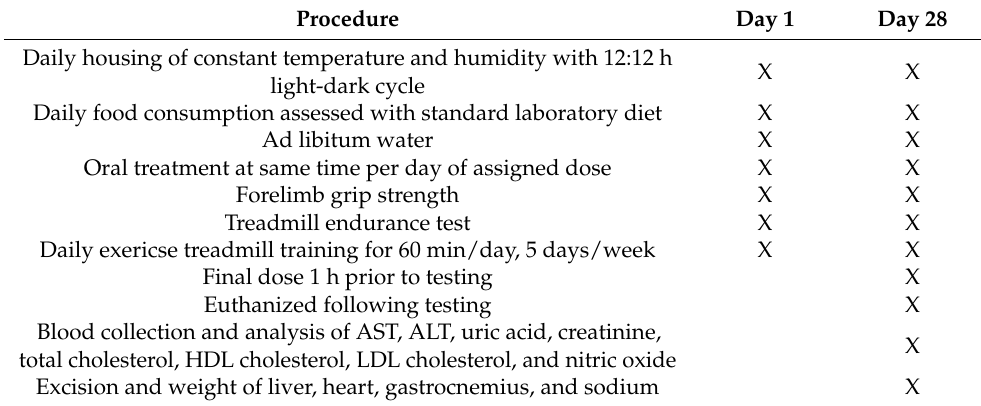
Table 1. Overview of research